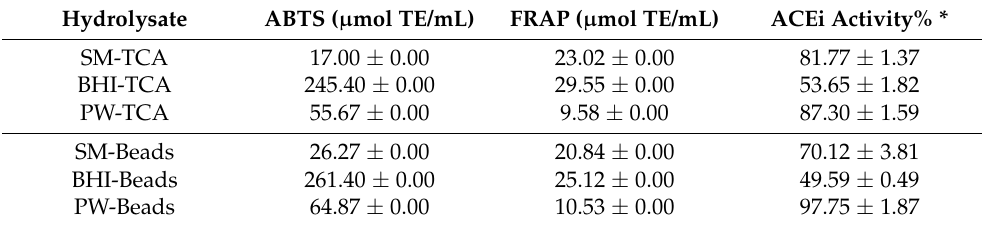
Figure 3. Chromatographic analysis of L. helveticus hydrolysates obtained with the three substrates (SM, BHI, and PW) and extracted by TCA at 4 °C or by using glass beads. The interference peak detected at 12 min corresponds to the TCA additive. Table 2. Summary of antioxidant (by ABTS and FRAP assays) and ACEi activities of hydrolysates. Values are expressed as mean values ± standard deviation (SD), n =